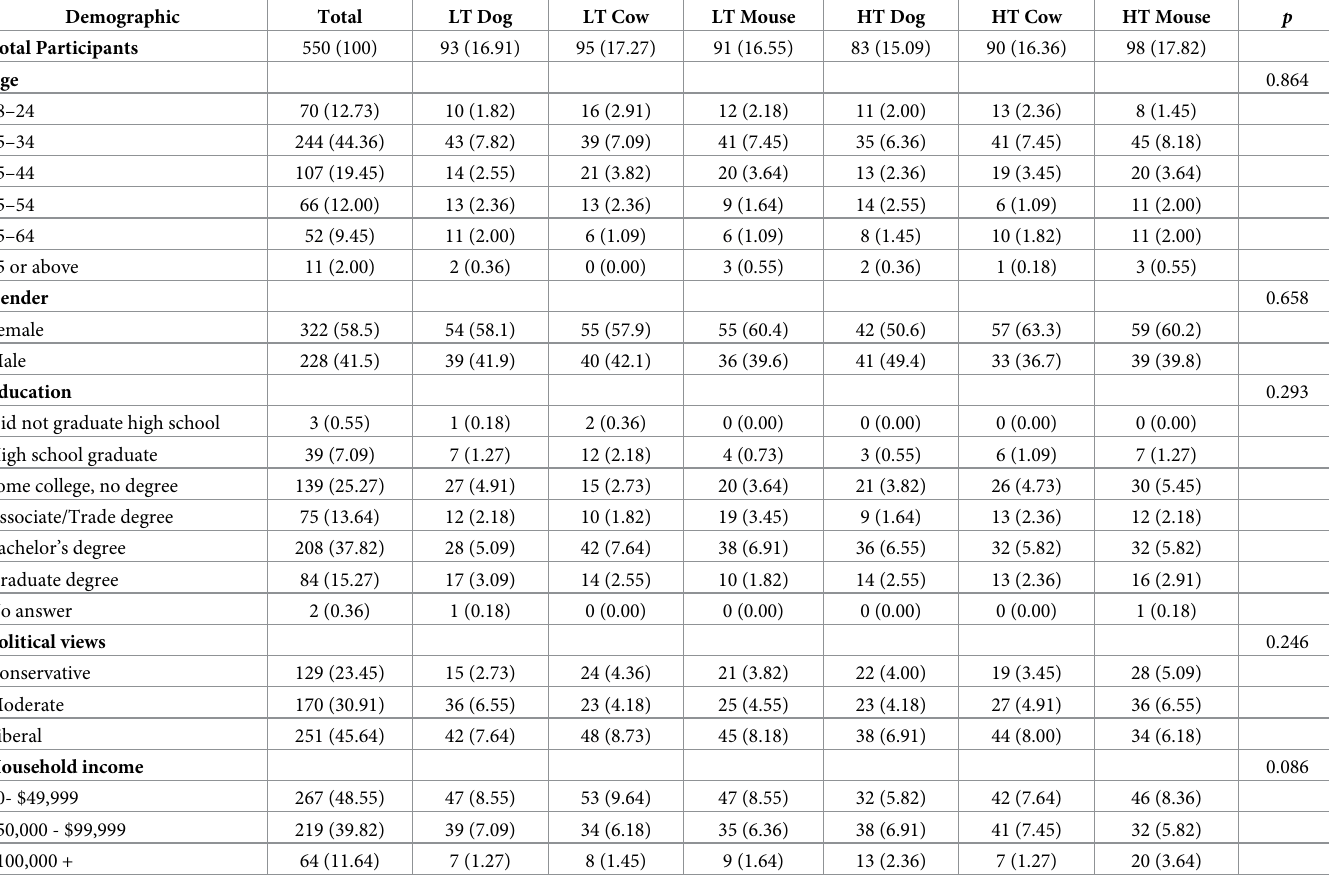
Table 2. The number (and percentage) of participants in each demographic category, and Fisher’s exact test assessing any contingency with treatment (LT = Low Transparency; HT = High Transparency).